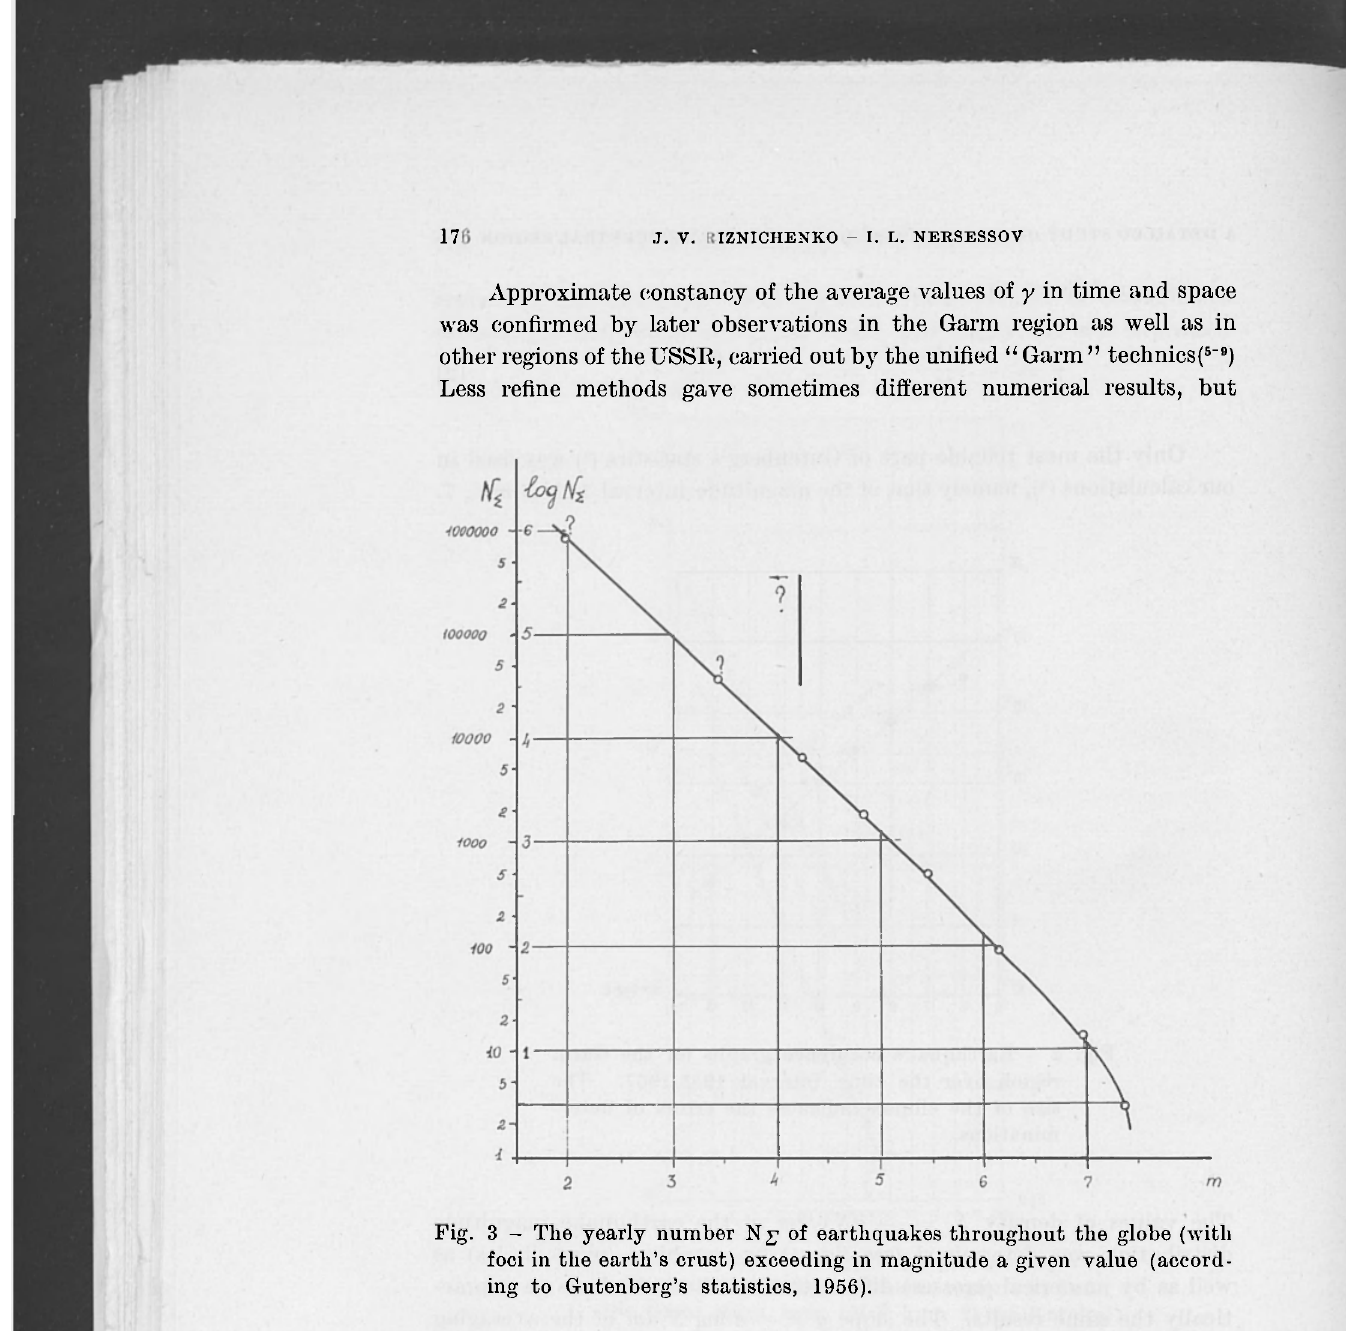
Fig. 3 - The yearly number Nj; of earthquakes throughout the globe (with foci in the earth's crust) exceeding in magnitude a given value (accord- ing to Gutenberg's statistics,